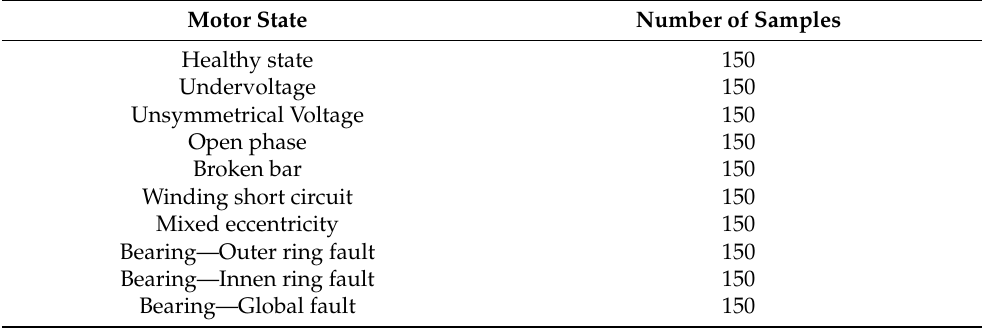
Table 2. List of inserted fault cases on the examined induction motor with 150 samples each with a length of 0.2 s for the validation of the neural network for fault detection.